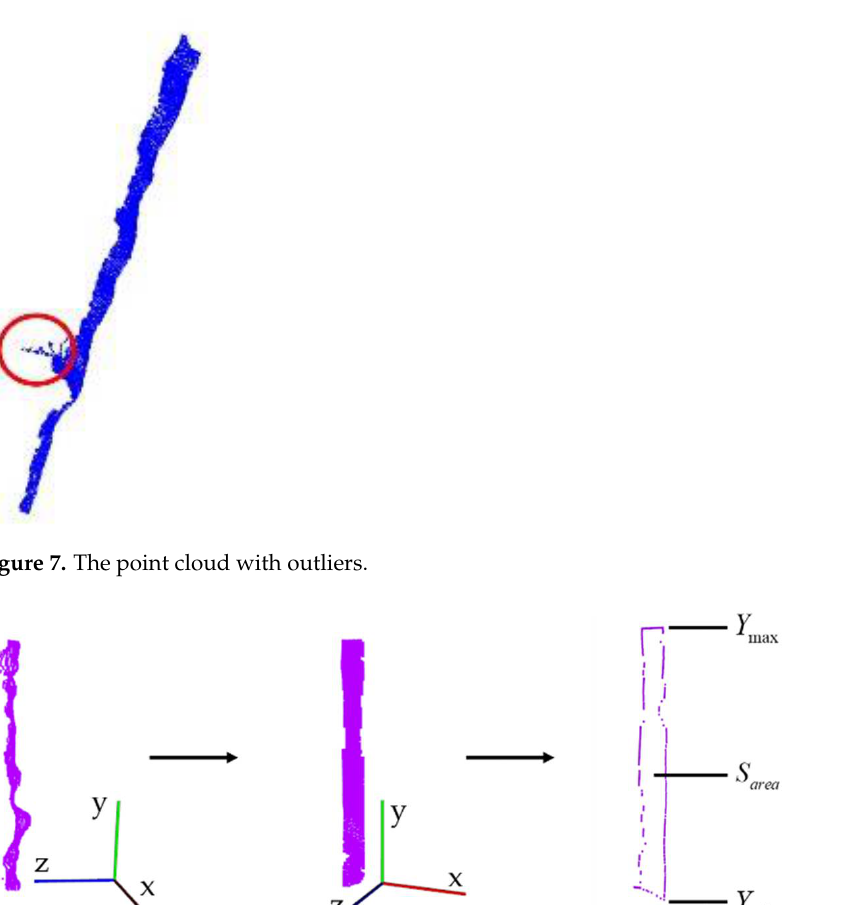
Figure 8. 2D point cloud contour extraction. ( a ) 3D point cloud. ( b ) the projection of the cloud on the X-Y plane. ( c ) the point cloud contour used to generate concave hull.